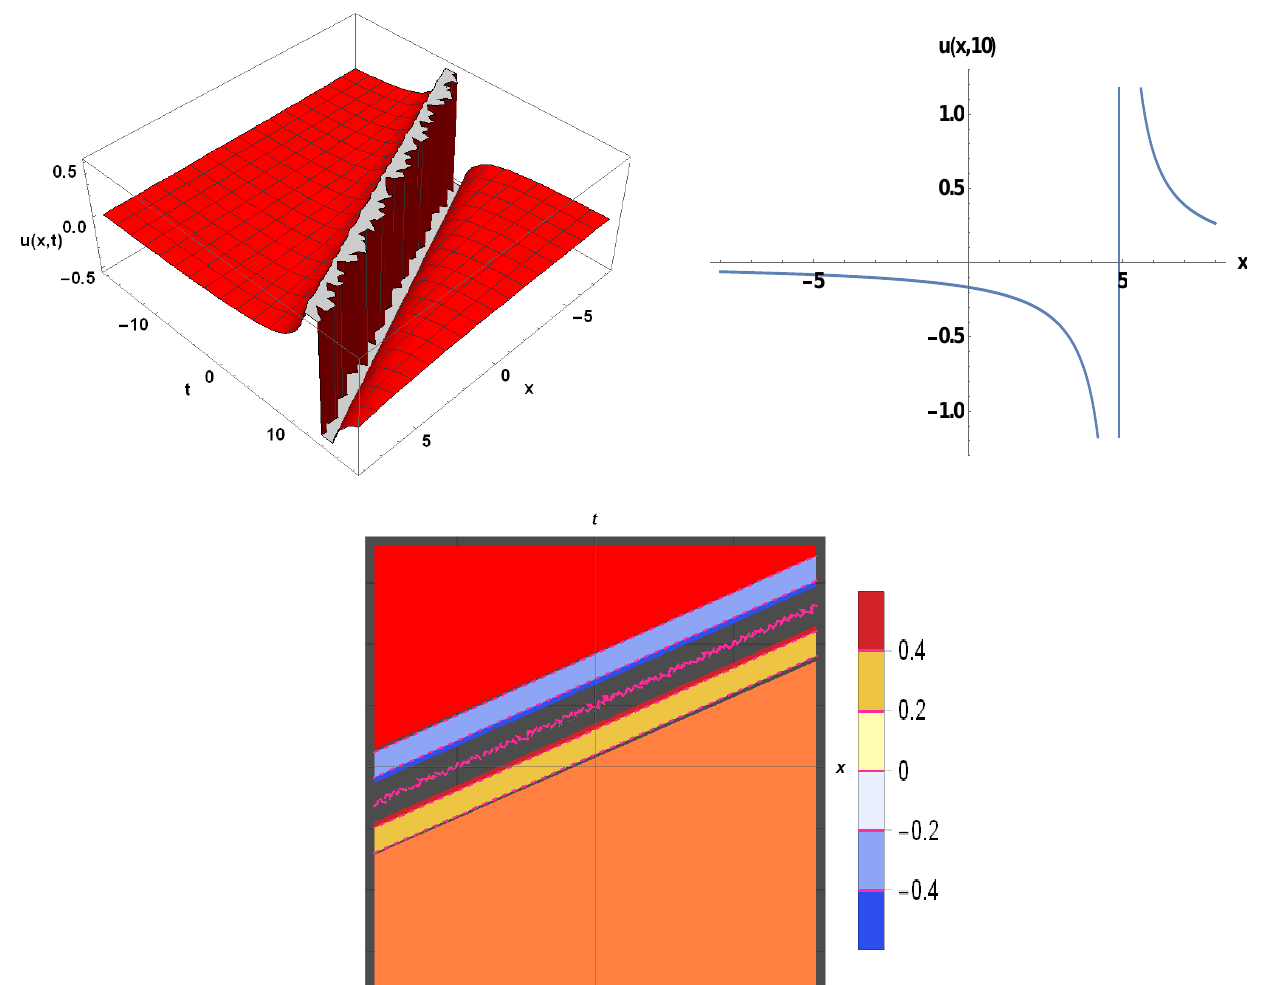
Figure 9. The solitary view of the 3D, 2D, and contour plots of U 9 ( x , t ). Our solutions are more exact when compared with the solutions of Baskonus